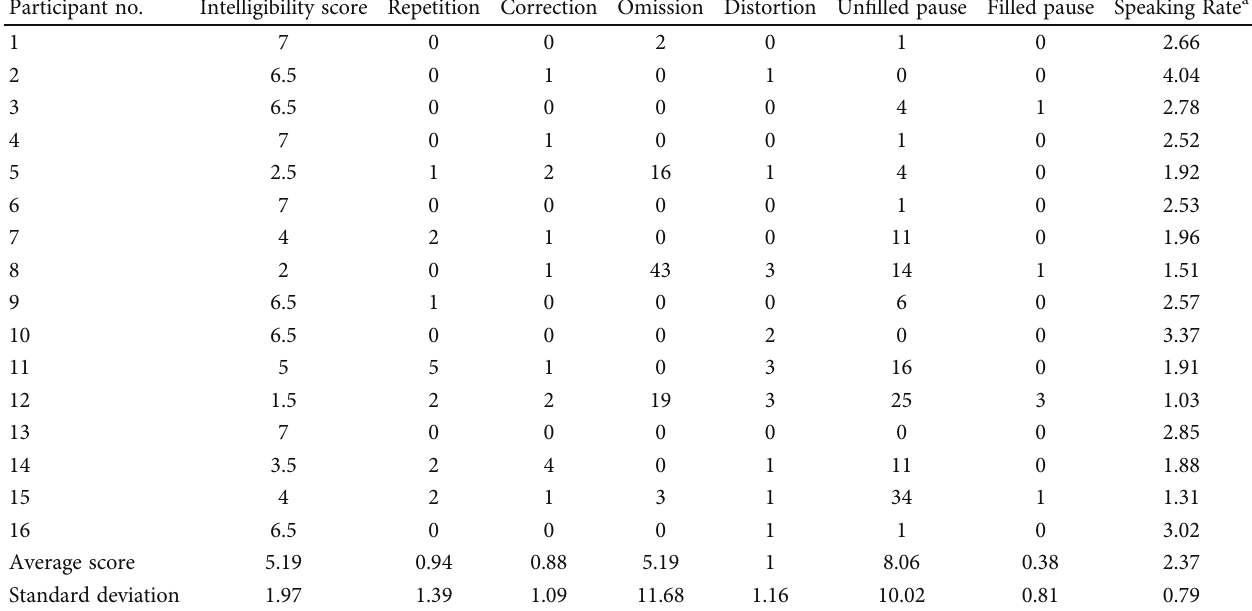
Table 2: The descriptive statistics of the speech intelligibility scores and fl uency indicators. Participant